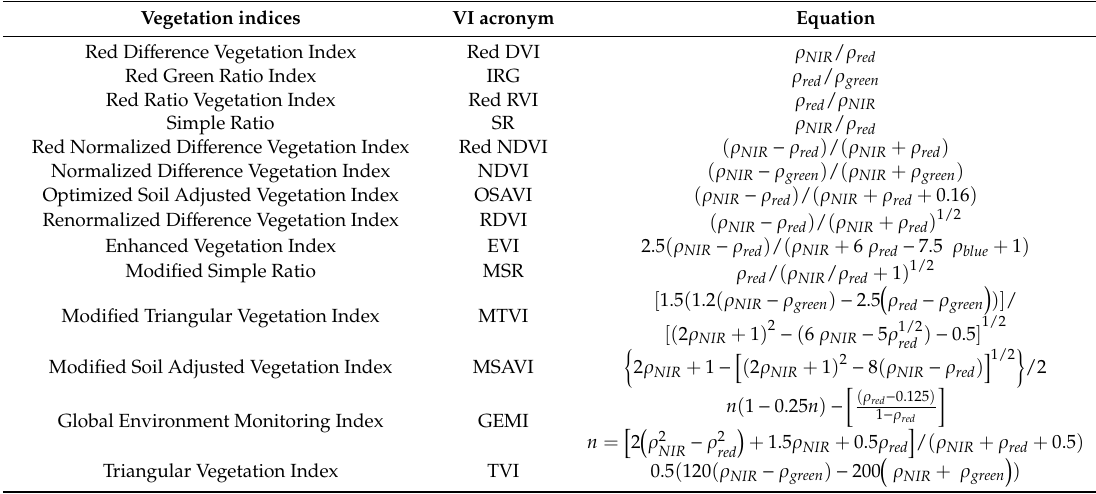
Table 1. Vegetation indices investigated.